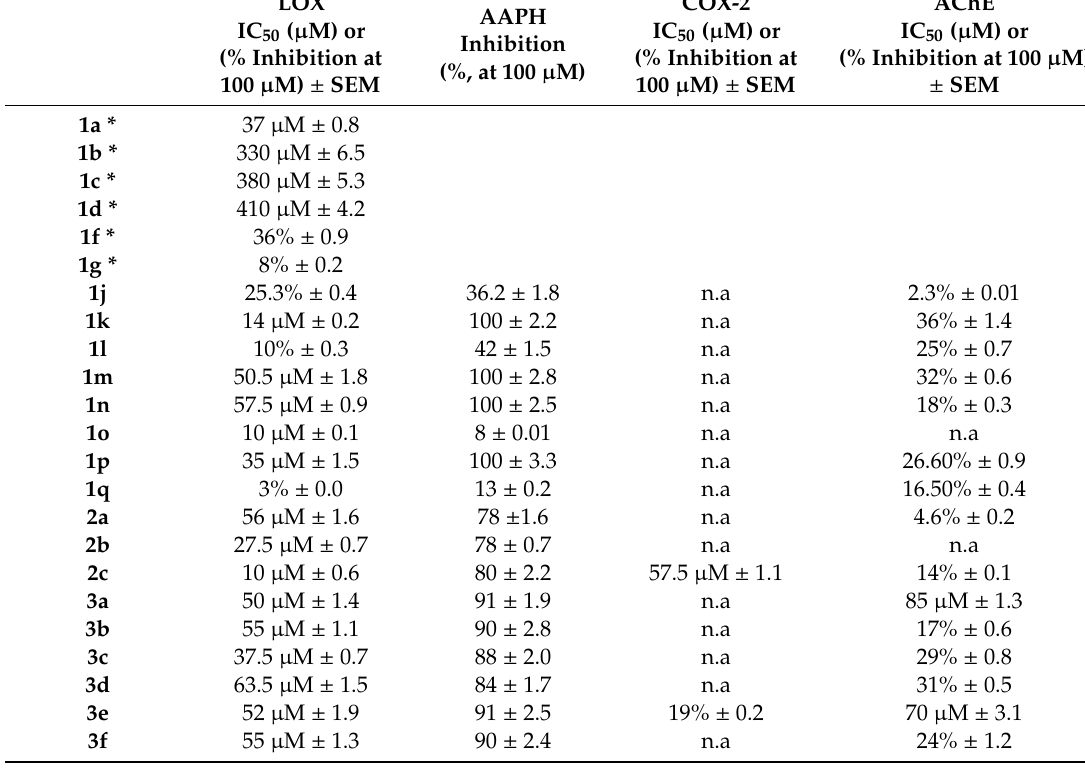
Table 6. % Anti-lipid peroxidation (2,2 (cid:48) -azobis(2-amidinopropane) hydrochloride—AAPH) of in vitro inhibition of soybean lipoxygenase, bovine cyclooxygenase (COX)-2, and eel acetylcholinesterase (AChE).